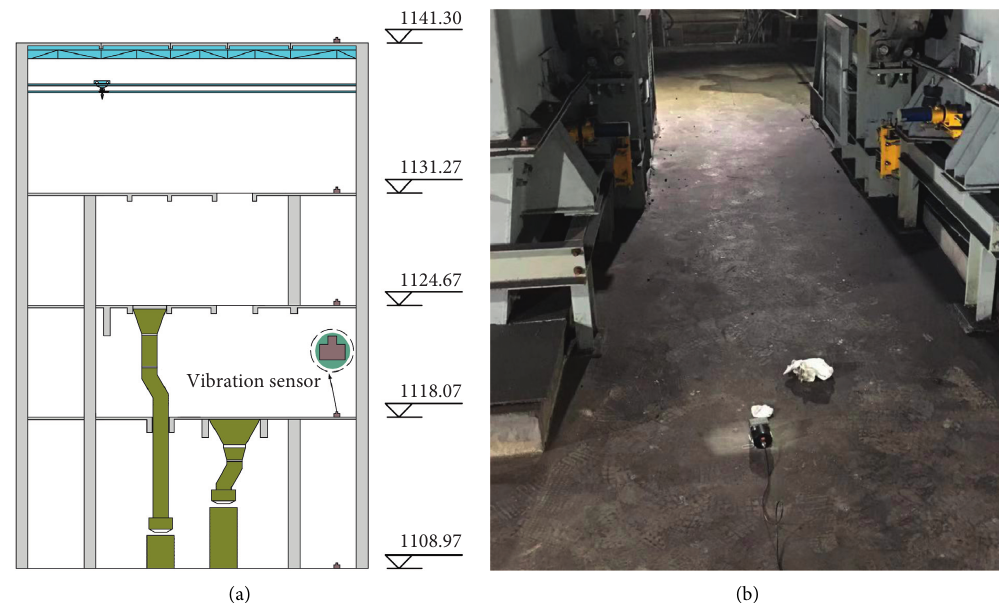
Figure 3: Modal test. (a) Arrangement of measurement points. (b) Vibration sensor on the second floor.